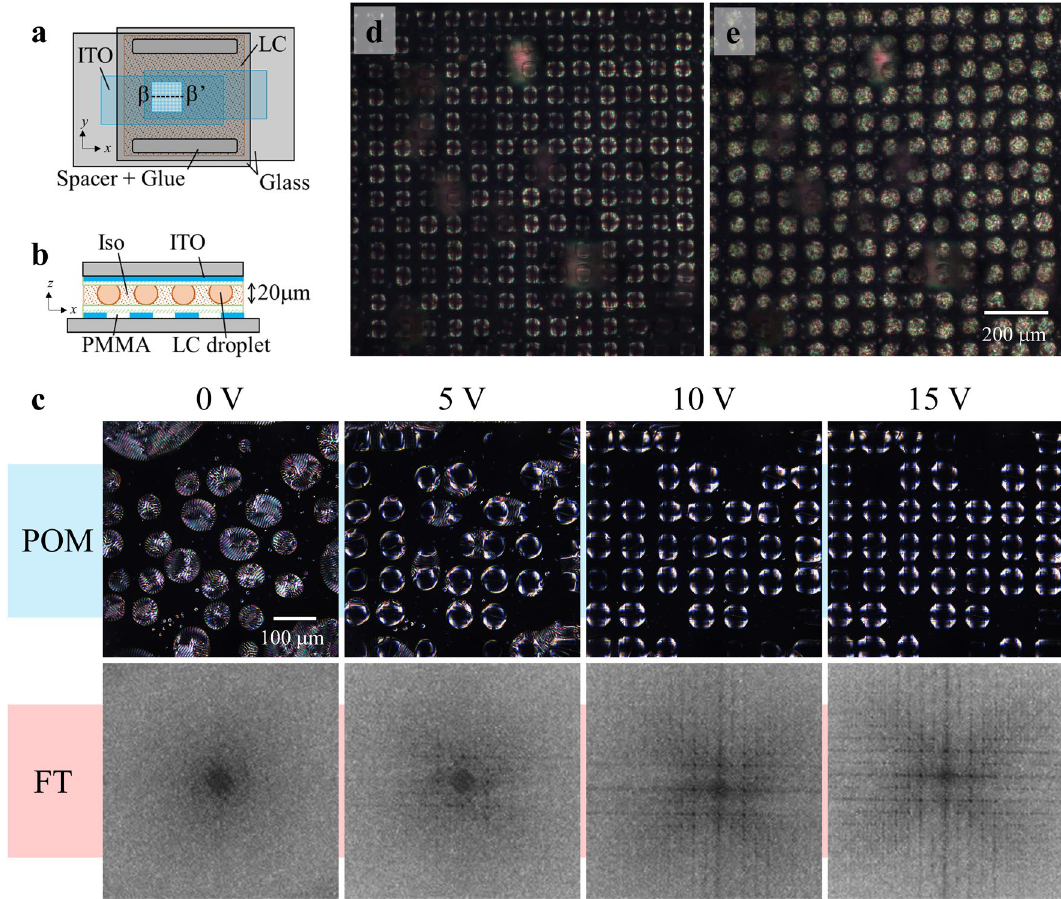
Figure 4. Manipulation of LCDs between micro-ITO electrodes. (a) Schematic top view of the microcapacitive device. Designed striped ITO electrodes perpendicularly on upper and lower glass substrates. (b) Cross- sectional view (β–β ′ ) of the microcapacitive device. The striped patterns of ITO electrodes on upper and lower glass substrates are parallel to the y - and x -axes, respectively. We set the cell thickness to 20 µm. (c) Morphology of LCDs within the microcapacitive device, POM images with voltages of 0, 5, 10, and 15 V. FT images were obtained by transferring POM images. (d) POM image of 15 × 15 LCD array with a voltage of 30 V. (e) POM image of LCD array after removing the voltage.